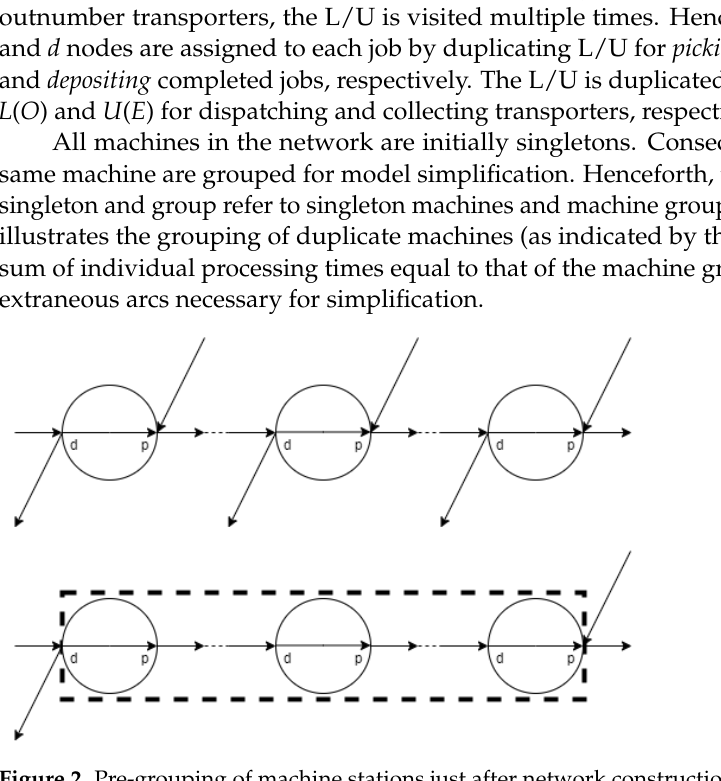
Figure 3. Instance of job pre-emption .